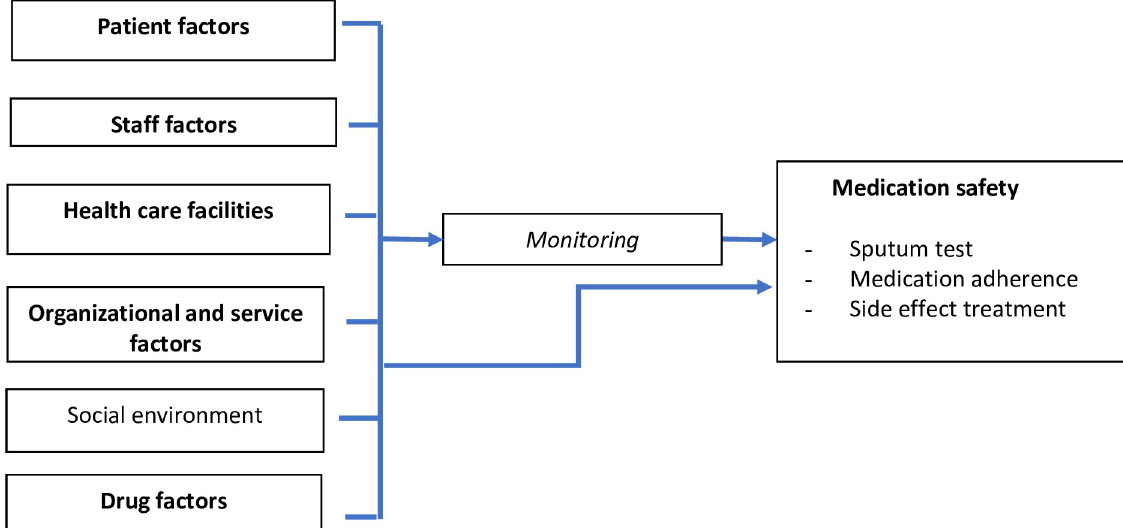
Fig 1. Conceptual framework (1st, 2nd, and 3rd phase of the study).